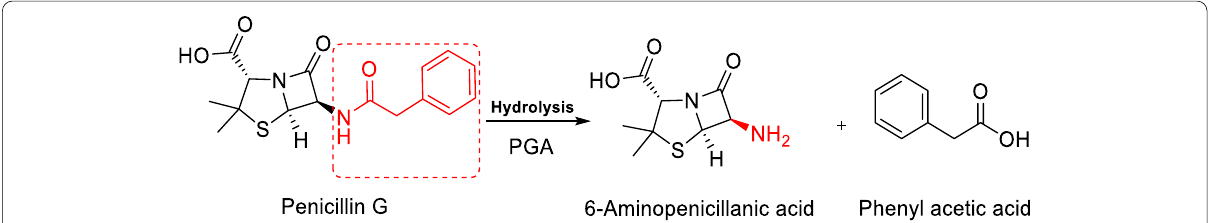
Fig. 1 Hydrolysis of penicillin G by PGA to synthesize